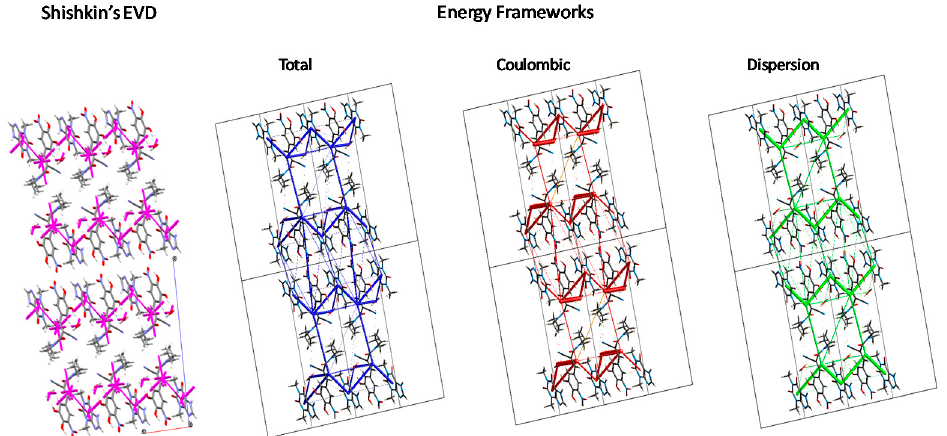
Figure 11. Shishkin’s Energy-Vector Diagrams (“hedgehogs”), in comparison with Energy Frame- works representing total interaction energy as well as the corresponding coulombic and dispersion components. A 2 × 2 × 2 supercell is shown along the b axis of the unit cell.